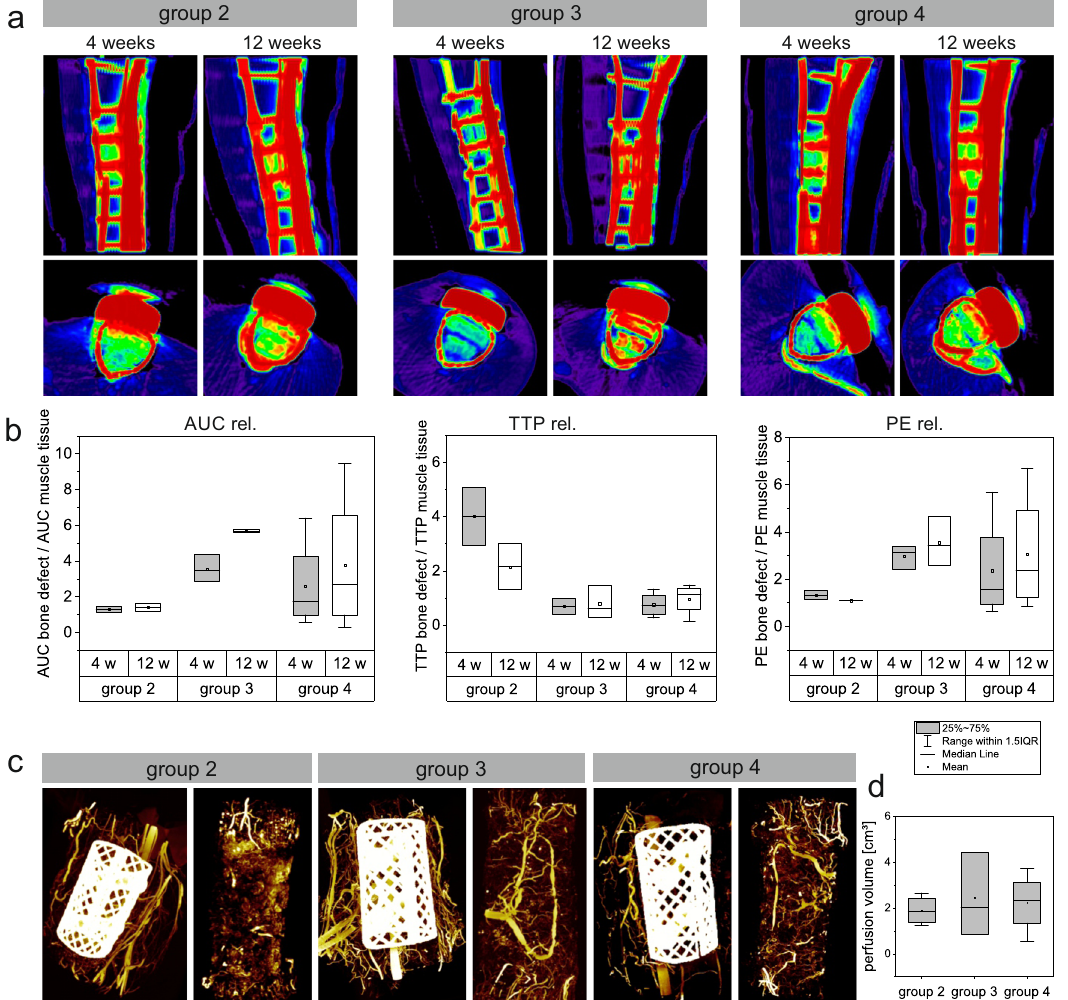
Fig. 4 Quanti fi cation of vascularization with computed tomography angiography and micro-CT. a , b Results of computed tomography angiography after 4 and 12 weeks. a In experimental groups 2, 3, and 4, an increase in perfused volume could be clearly shown. b Quanti fi cation of perfused volume in the bone defect area was measured relatively compared to muscle tissue in each animal. Graphs show relative values (y-axis) of the area under the curve (AUC), time to peak (TTP), and peak enhancement (PE) in different experimental groups after 4 and 12 weeks (x-axis). c , d Micro-CT of bone defects. c Bone defects were perfused with the radiopaque contrast agent Micro fi l ® . Group 2, 3, and 4: Left picture defect with implantation chamber, right picture after removal of implantation chamber. d Quanti fi cation of perfusion volume (y-axis) in different experimental groups